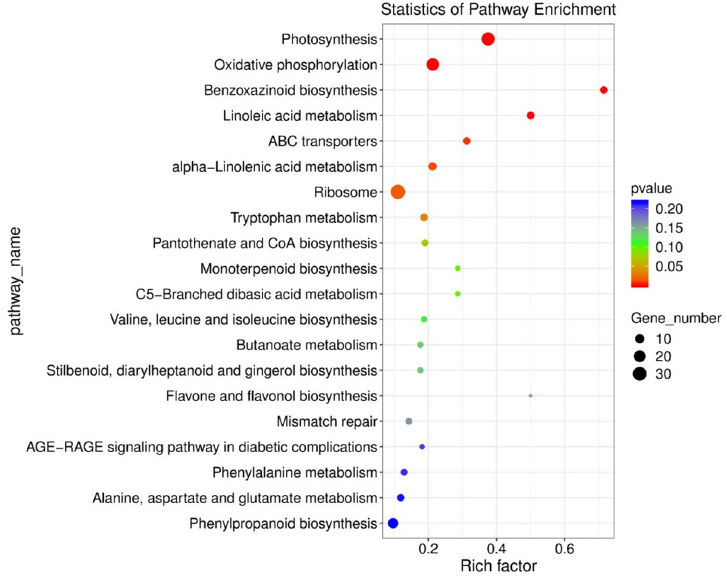
Fig 4. Enrichment analysis of the differentially expressed gene at KEGG in maize. The horizontal axis indicates the degree of enrichment (Rich factor), and the vertical axis indicates the enriched KEGG pathway; the size of the dot indicates the number of differential genes enriched in a certain KEGG pathway; the color of the dot indicates p values; Rich Factor represents the number of differential genes belonging to a certain KEGG pathway/total number of genes belonging to this KEGG pathway. The higher the Rich factor, the higher the enrichment of the KEGG